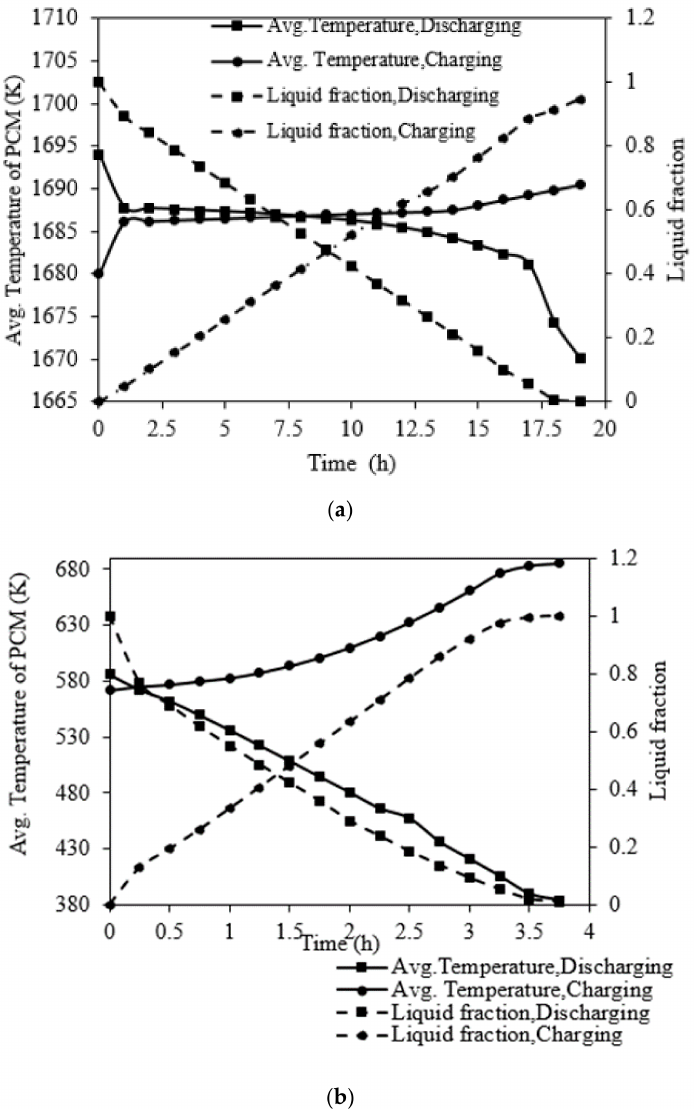
Figure 17. Comparison of thermal performance during charging and discharging. ( a ) Silicon domain and ( b ) NaNO 3